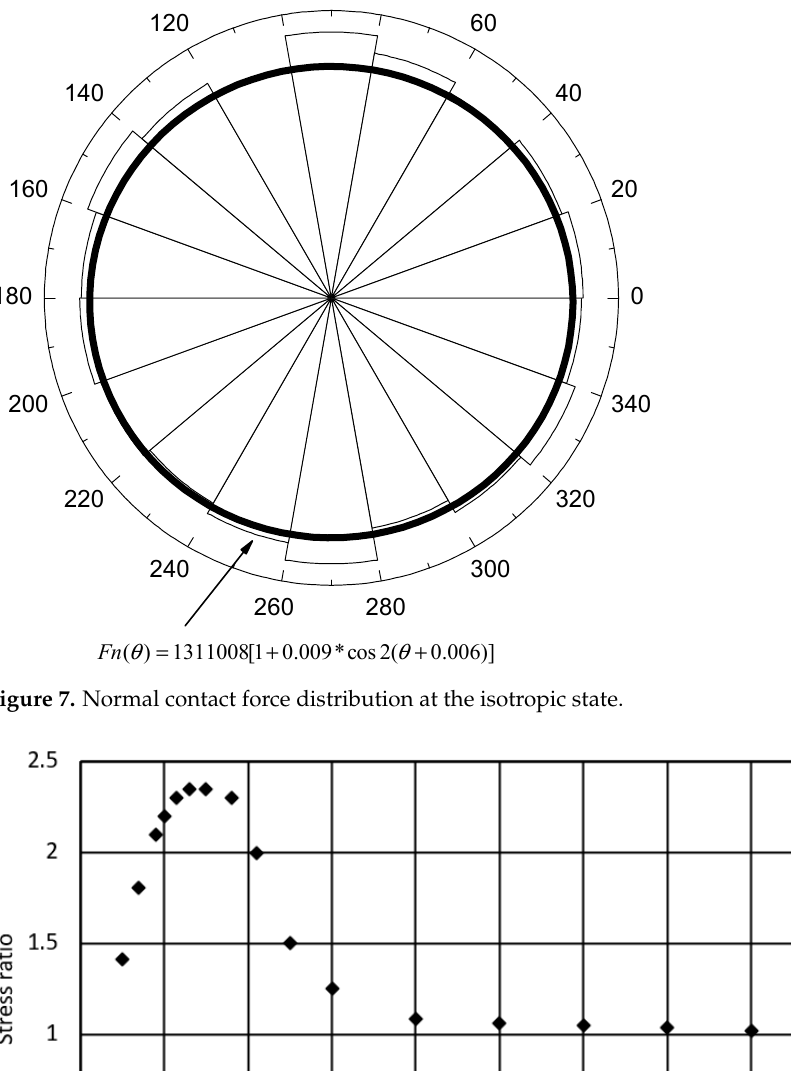
Figure 6. Normal contact distribution at the isotropic state.